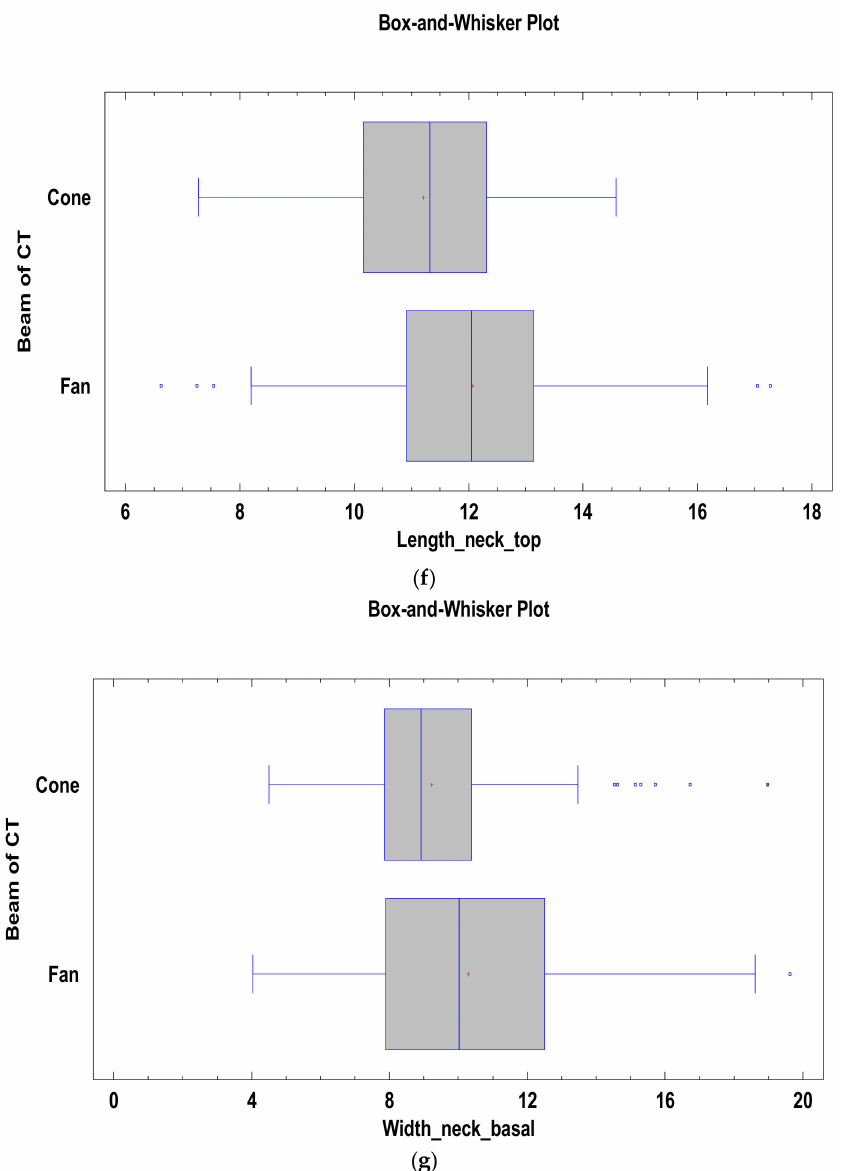
Figure 3. Results showing statistically significant ( p < 0.05) differences between measurements: Length_neck_basal ( a ), Ramus height ( b ), Length_neck_middle ( c ), Thickness_sigmoid_notch ( d ), Width_head ( e ), Length_neck_top ( f ), Width_neck_basal ( g ) depending on the CT type subjected to